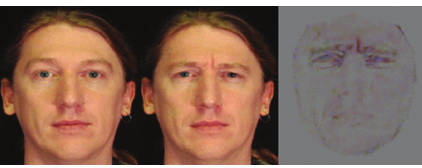
Figure 2: ERI of frown expression.